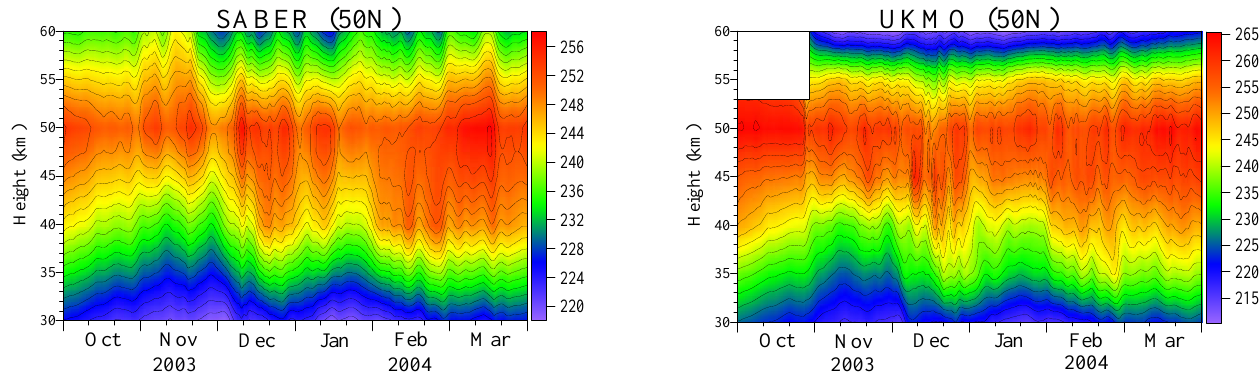
Figure 1 Fig. 1. Altitude-time cross section of the zonal mean temperature seen in the TIMED/SABER data (left plot) and in the UKMO assimilated data (right plot) at 50 ◦ N for the period of time between 1 October 2003 and 31 March 2004.